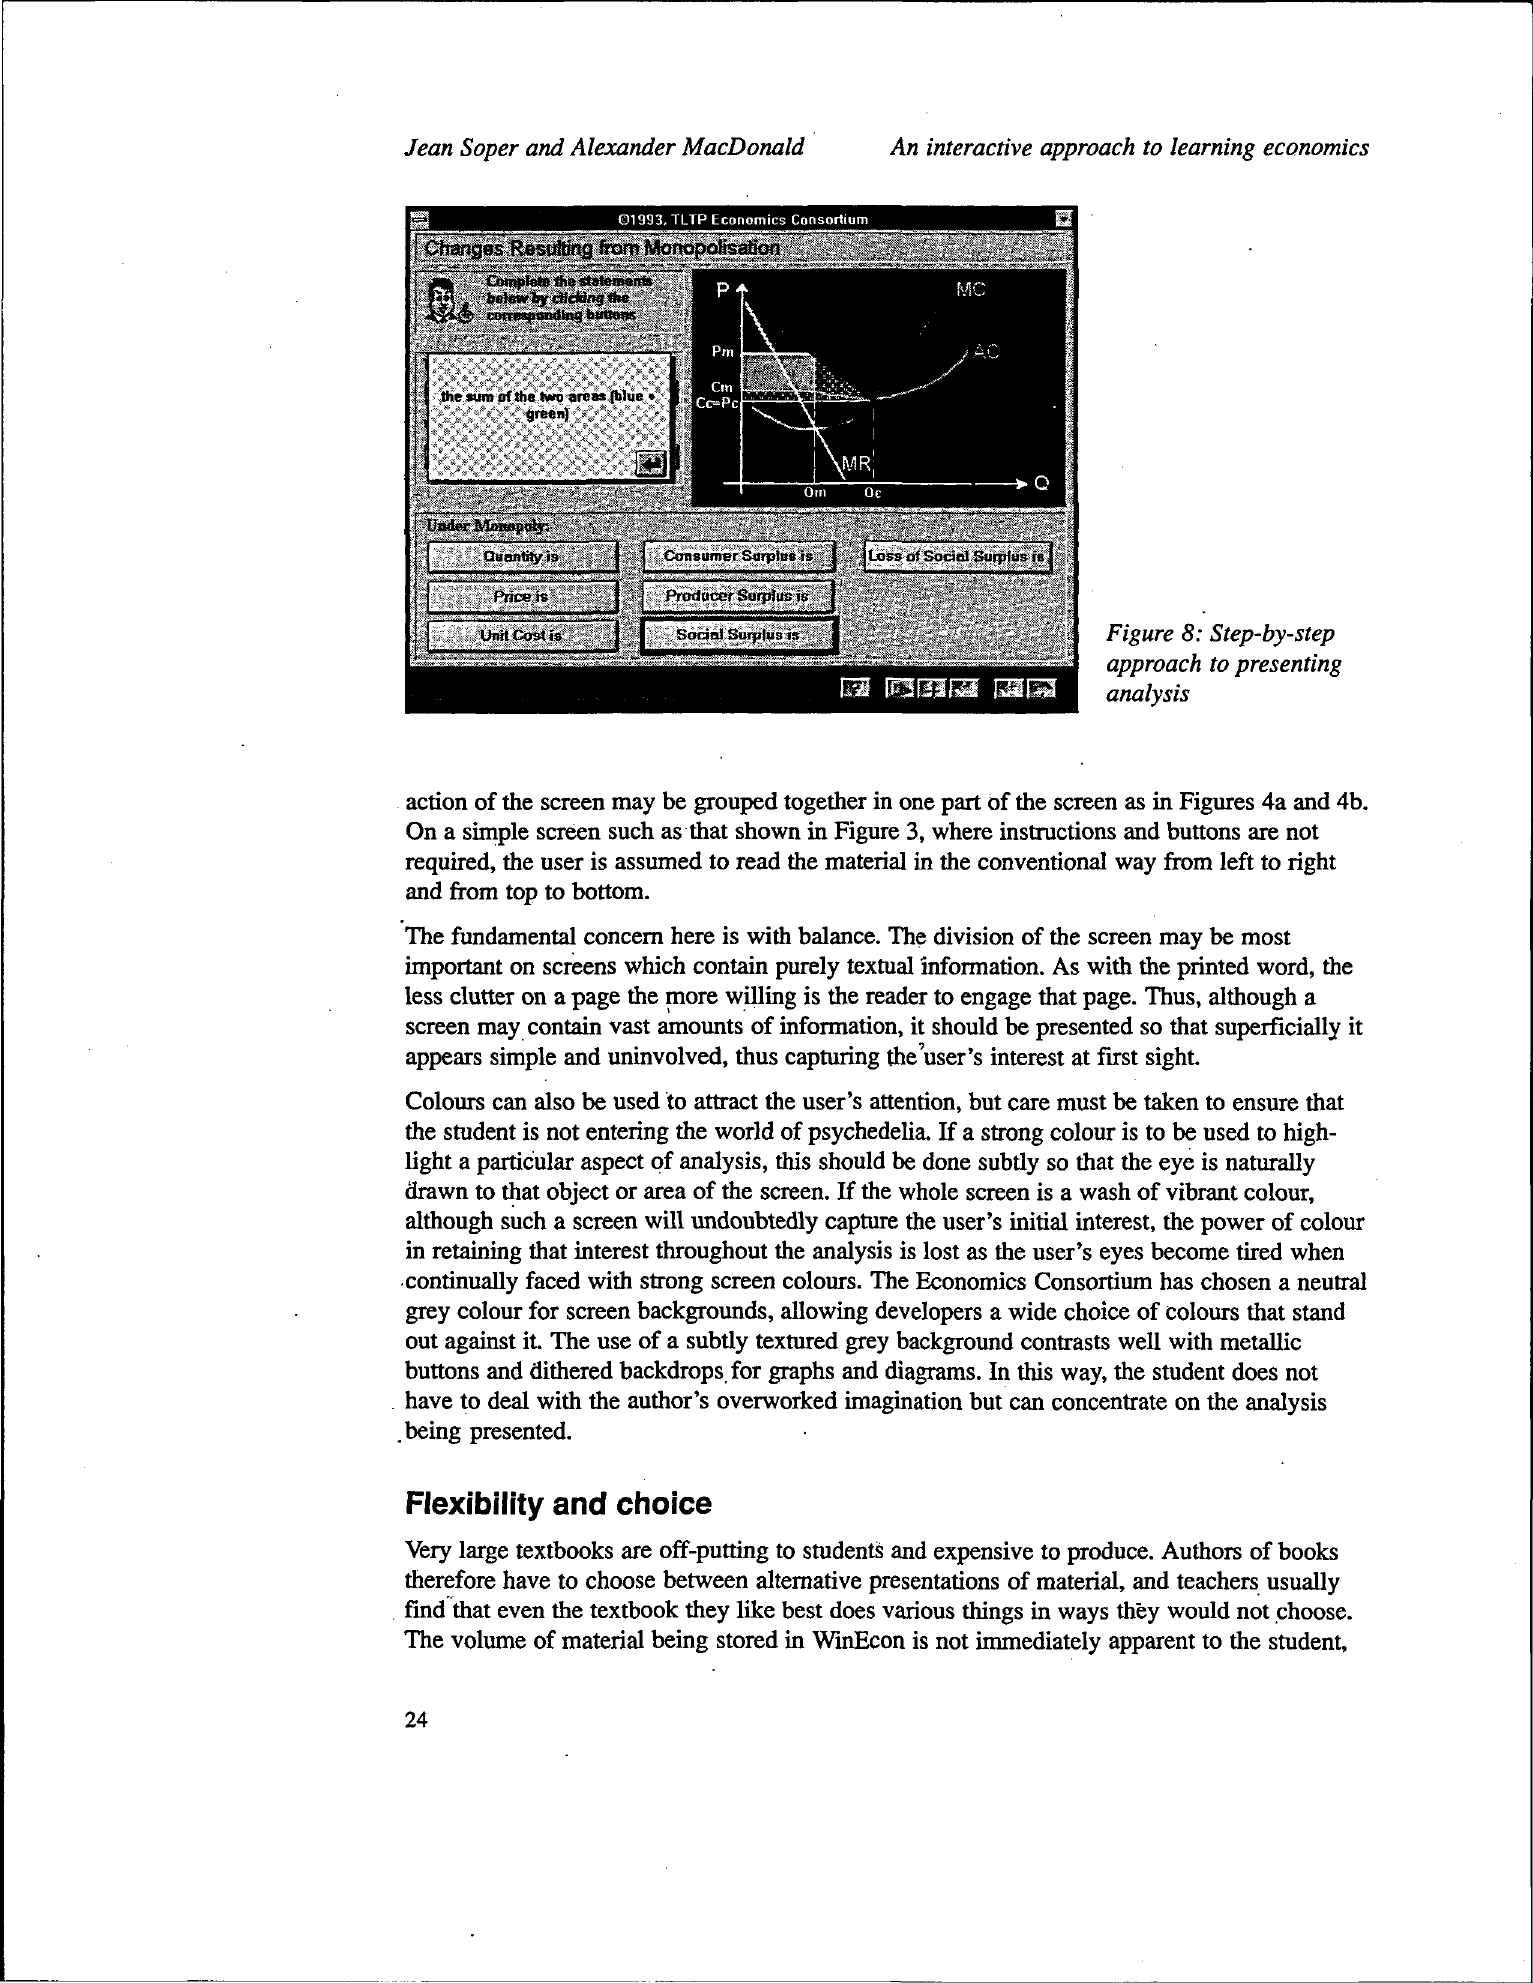
Figure 8: Step-by-step approach to presenting